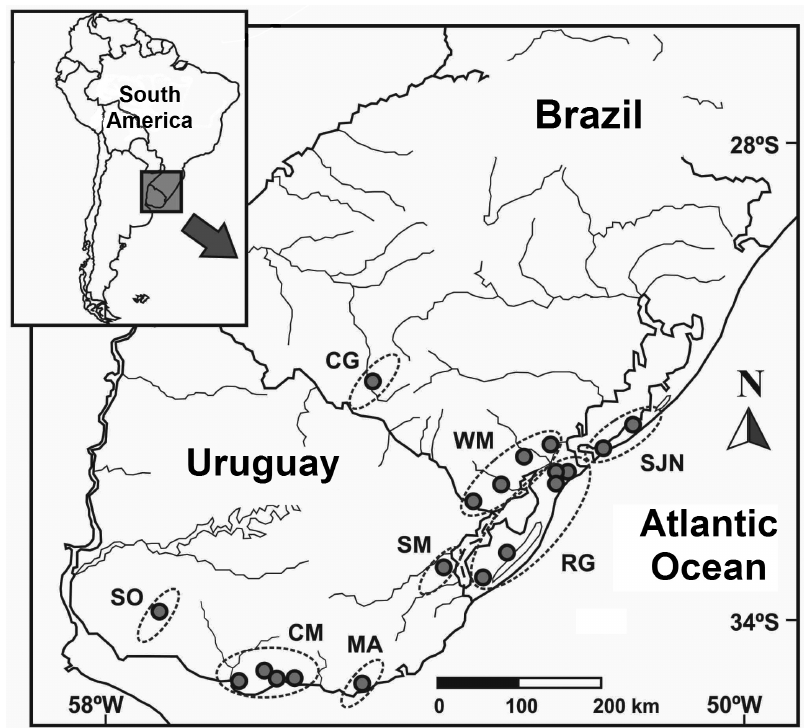
Figure 1 - Map with locations of Scapteromys tumidus sampled populations and geographic clusters in southern Brazil and Uruguay. Information on voucher specimens are listed in Appendix